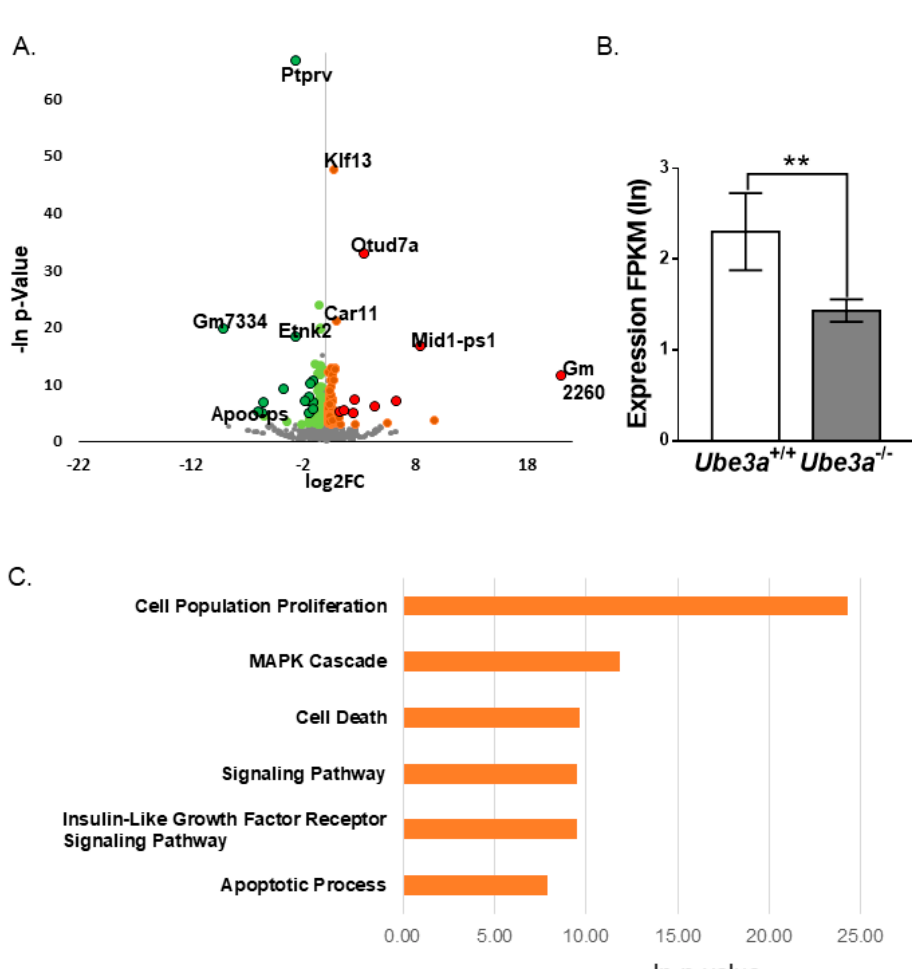
Figure 4. RNA-seq analysis reveals di ff erentially expressed genes enriched in apoptotic and proliferative pathways. ( A ) Volcano plots representing the distribution of the gene expression fold changes and p -values in Ube3a − / − compared to Ube3a +/+ MEFs. A total number of 7365 genes were used for the analysis. Genes with fold changes > 1.5 and p -values < 0.01 are indicated in red circles. Genes with fold changes > 1.2 and p -values < 0.01 are indicated in orange. Genes with fold changes < 1.5 and p -values < 0.01 are indicated in green circles, and genes with fold changes < 0.8 and p -values < 0.01 are indicated in light green. Genes with no di ff erence in expression levels are indicated in grey. ( B ) Androgen receptor (Ar) expression profile. Androgen receptor is significantly downregulated (DeSeq2 p -value = 0.0053, Fold Change = 0.63) in Ube3a − / − MEFs. ( C ) Enrichment analysis of di ff erentially expressed genes. Topmost significantly enriched biological processes of di ff erentially expressed genes associated with Ube3a − / − samples as analyzed by PANTHER. (** p <